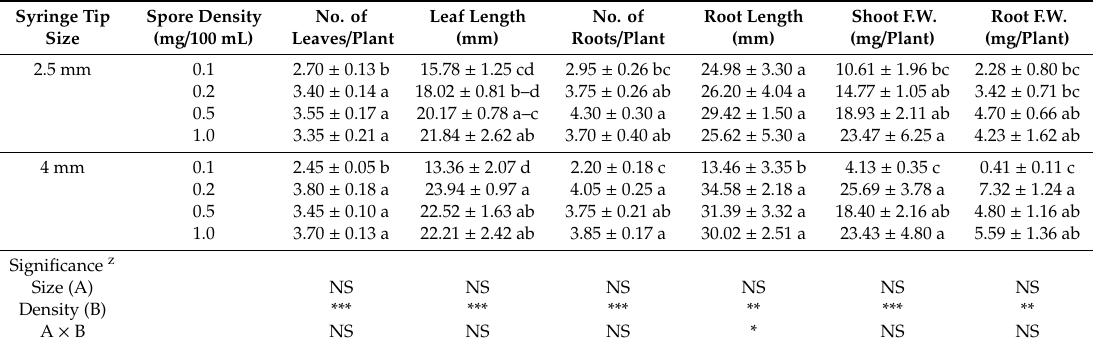
Table 2. E ff ect of syringe tip size and spore density on the growth of sporophytes cultured from bracken SFS (synthetic seeds using fern